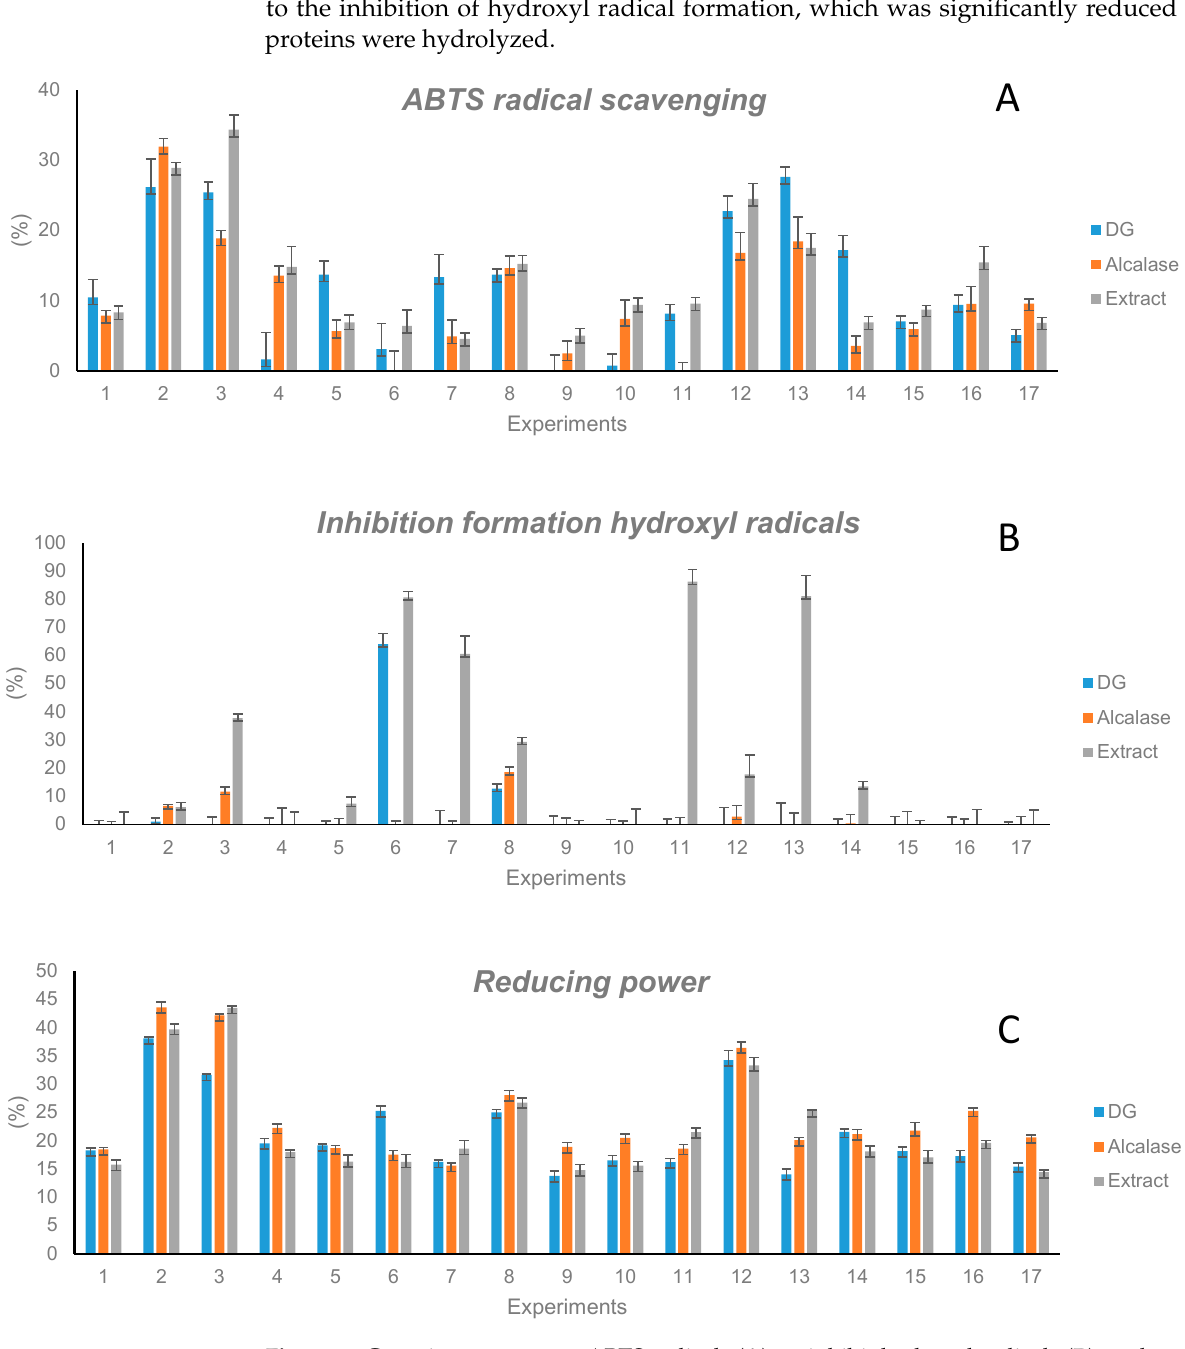
Figure 3. Capacity to scavenge ABTS radicals ( A ), to inhibit hydroxyl radicals ( B ), and to reduce oxidant molecules ( C ) of the 17 extracts and their hydrolyzates obtained by gastrointestinal digestion (GD) or by Alcalase hydrolysis.